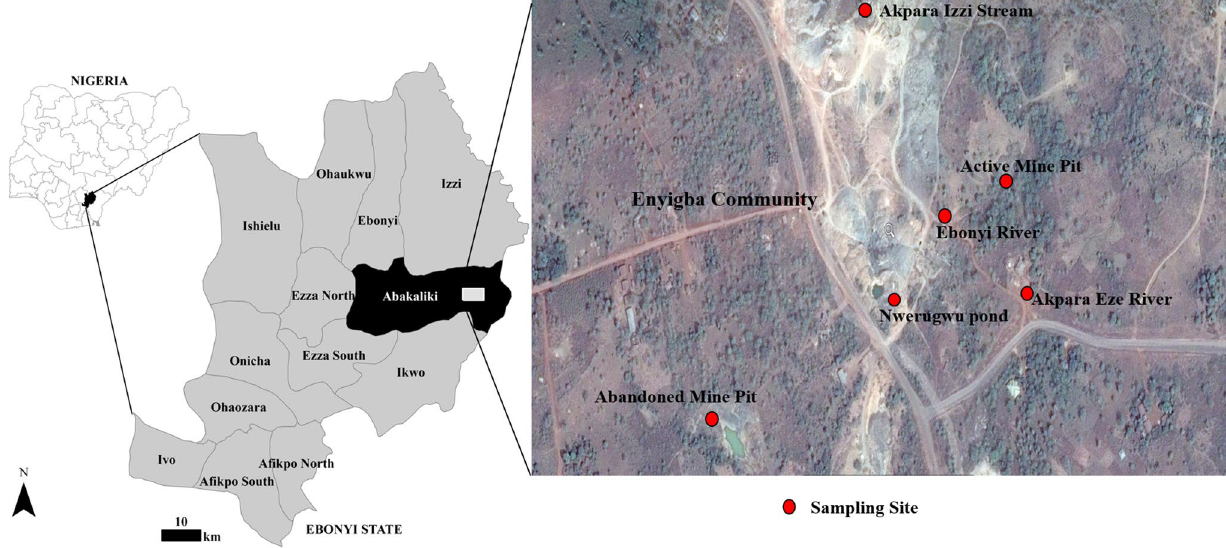
Fig. 1 The map of Enyigba community showing the sampling sites (insets: map of Nigeria showing Ebonyi State and map of Ebonyi State showing location of Enyigba community: The data for the map